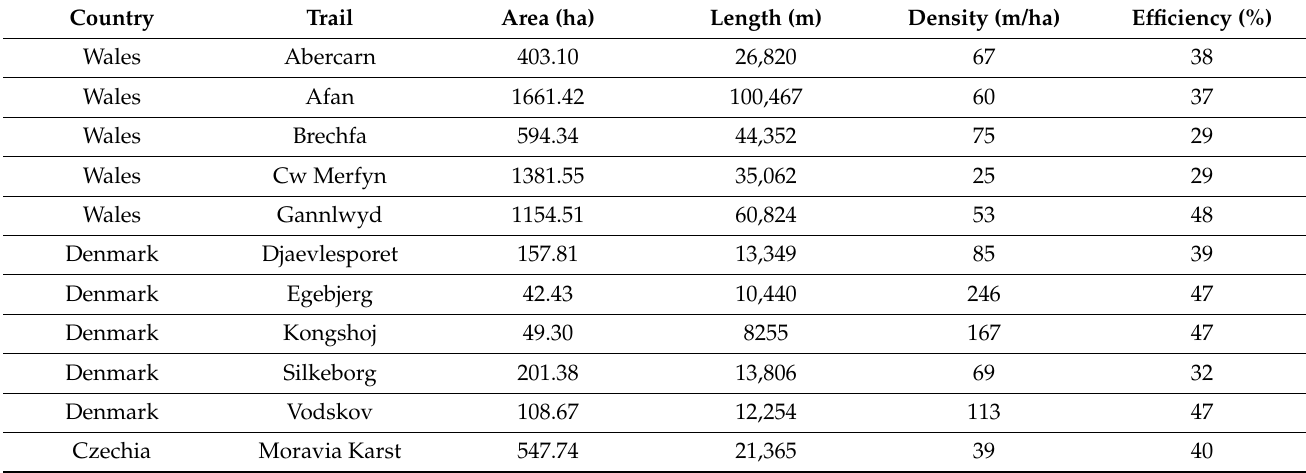
Table 5. Characteristics of the single-track areas